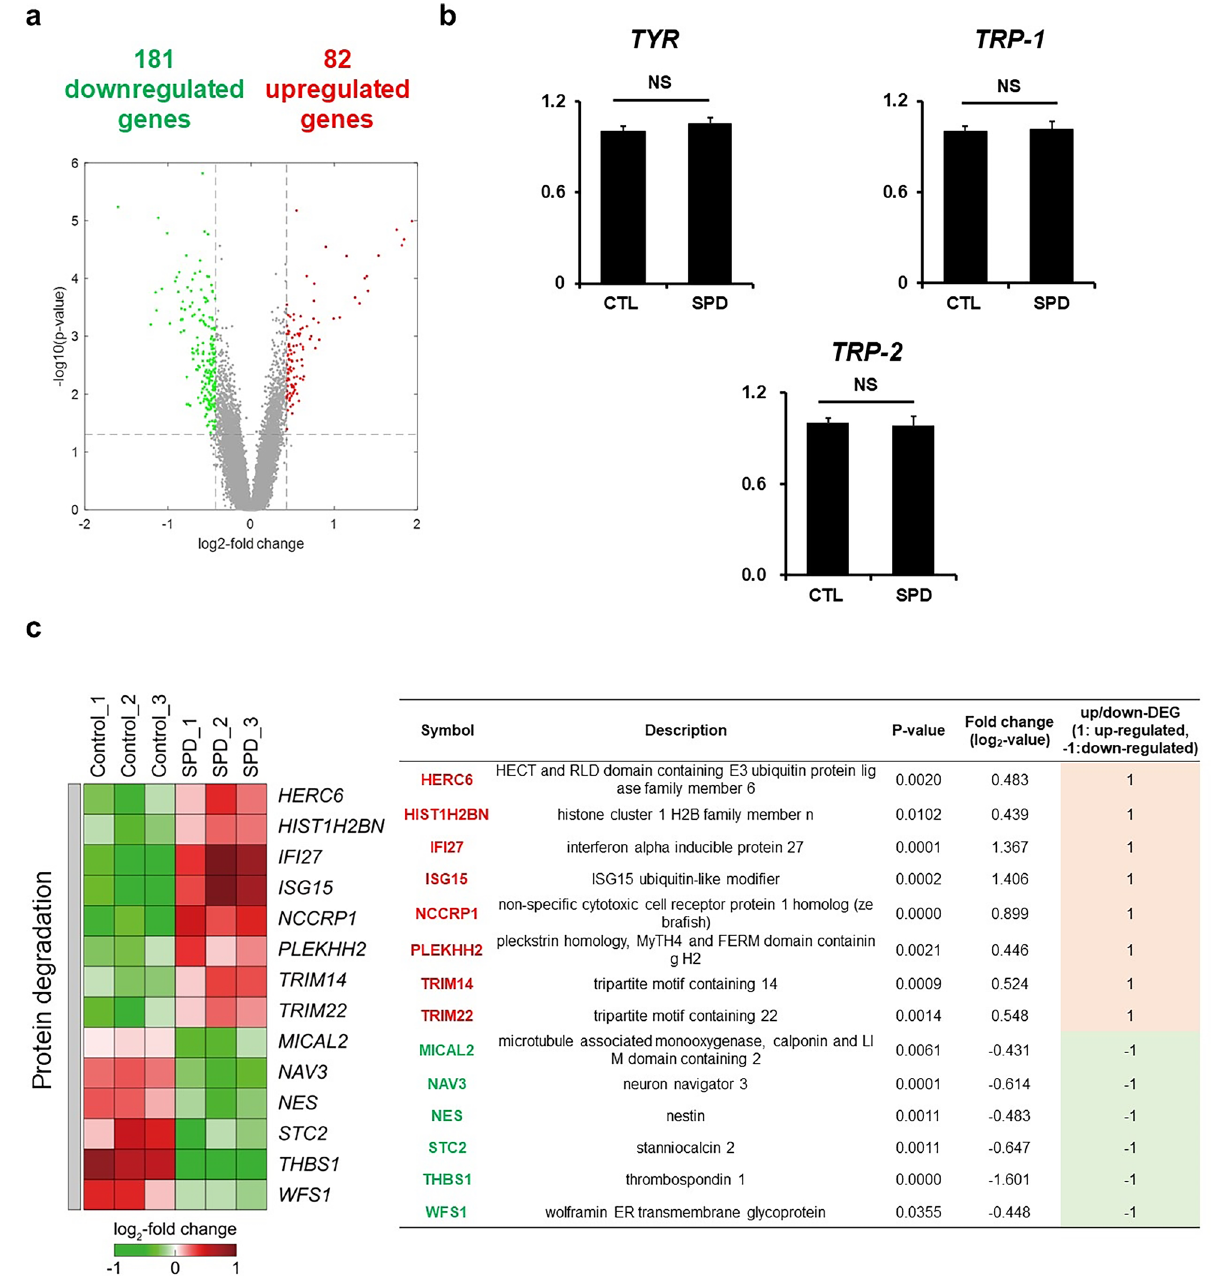
Figure 2. A systematic exploration reveals that SPD treatment modulates genes involved protein degradation. ( a ) RNA-sequencing analysis of 1 µg of total RNA of primary melanocytes after treatment with 1 μM of SPD for 7 days revealing the upregulation (red) and downregulation (green) in gene expression levels. ( b ) mRNA expression levels of melanogenesis-related genes of primary melanocytes after treatment with 1 μM of SPD for 10 days. The data represent the results of three independent experiments. CTL: control, NS: non-significant. ( c ) RNA-sequencing analysis of 1 µg of total RNA of primary melanocytes after treatment with 1 μM of SPD for 7 days revealing the upregulation (red) and downregulation (green) in expression levels of genes involved in protein